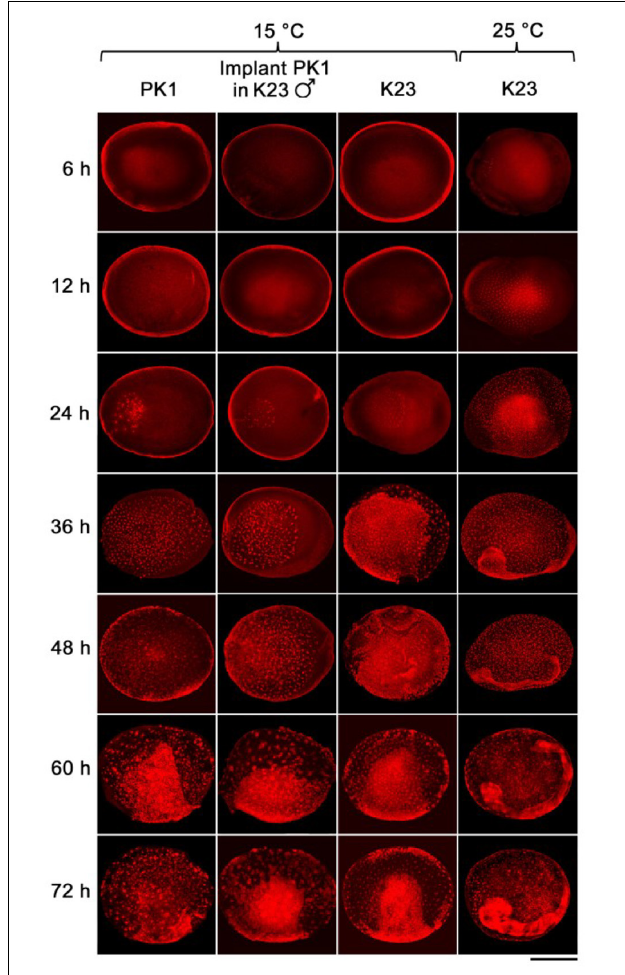
FIGURE 2 | The rate of development of parthenogenetic and univoltine embryos of B. mori at different incubation temperatures. Embryogenesis was studied during 72 h AEA. Eggs were incubated at 15 ◦ C, except for the last column where embryos were maintained at 25 ◦ C. The time after egg activation is indicated on the left side of the panel. PK1, parthenogenetic eggs from PK1 ovaries; implant PK1 in K23 (cid:124) , parthenogenetic PK1 eggs from ovarian implants that developed in K23 males; K23: fertilized eggs from endogenous K23 ovaries. Scale bar: 500 µ m.